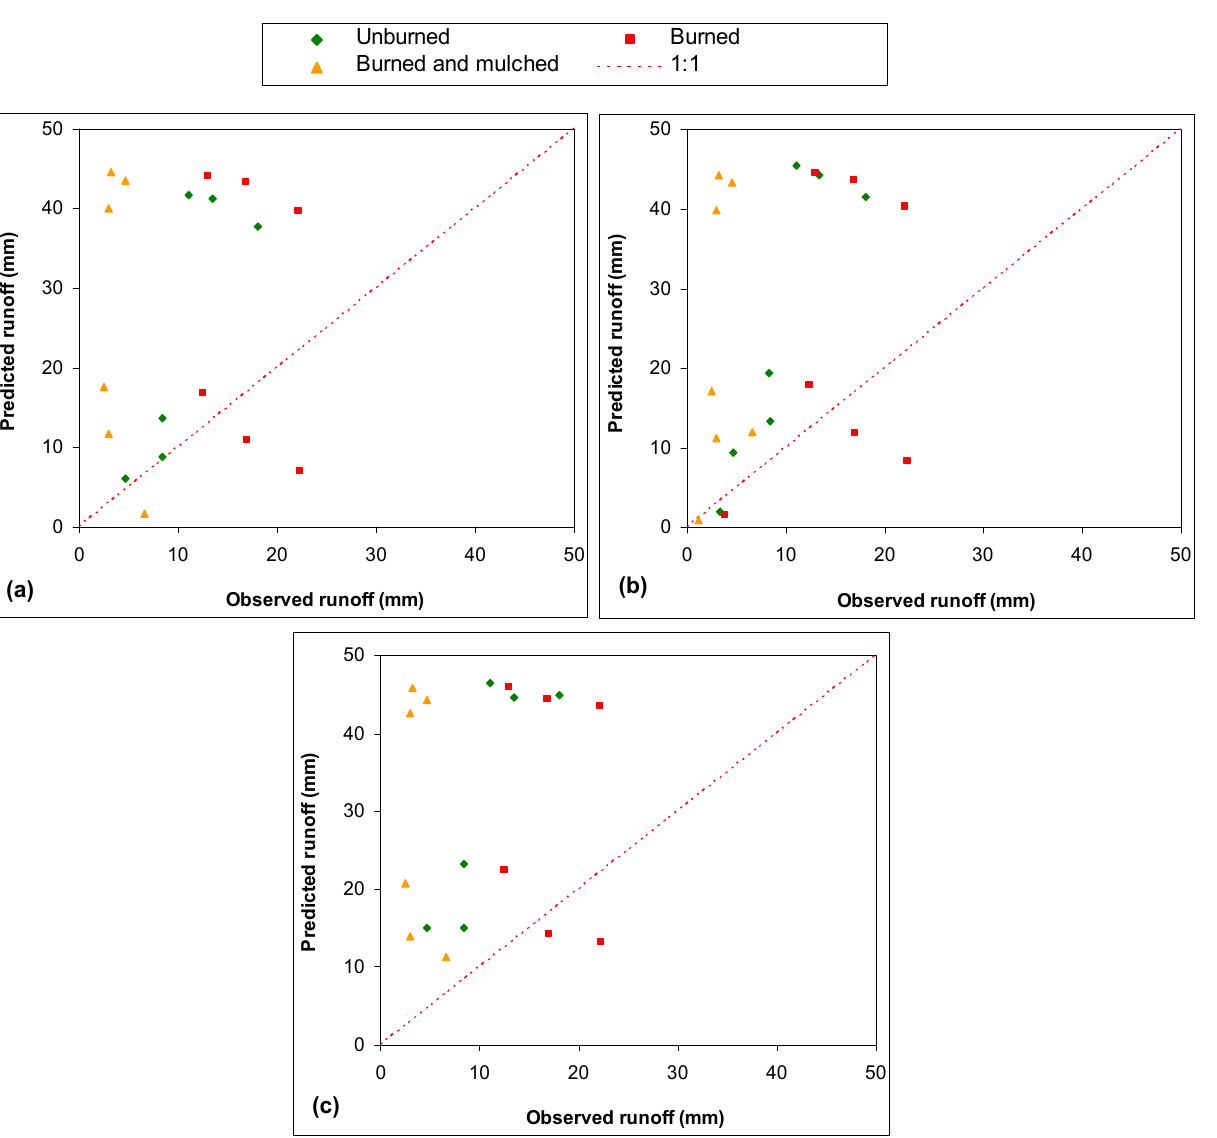
Figure 6. Scatter plots of runoff volumes observed in forest sites (( a ), pine; ( b ), chestnut; ( c ), oak) subject to prescribed fire and soil mulching with fern vs. predicted using the Horton model.